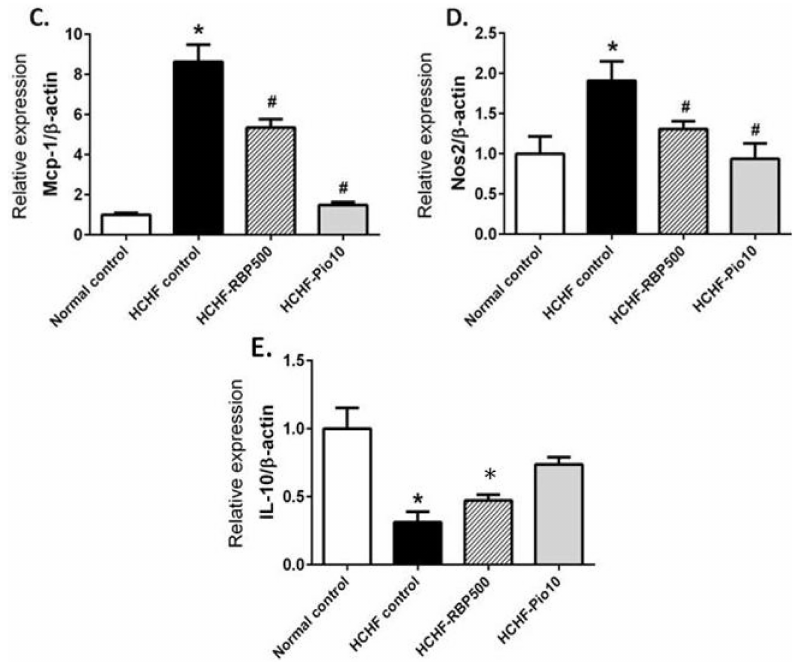
Figure 6. Effects of RBP on expression levels of inflammatory genes Il-6 ( A ); Tnf- α ( B ); Mcp-1 ( C ); Nos2 ( D ) and Il-10 ( E ) in HCHF-fed rats. Oral administration of RBP 500 mg/kg or pioglitazone 10 mg/kg daily for 6 weeks significantly decreased the expression of Il-6 , Tnf- α , Mcp-1 and Nos2 . RBP 500 tended to increase expression of the anti-inflammatory gene Il-10 as compared to the HCHF-control group ( * : p < 0.05, significant increase as compared to normal controls; # : p < 0.05, significant decrease as compared to HCHF-control